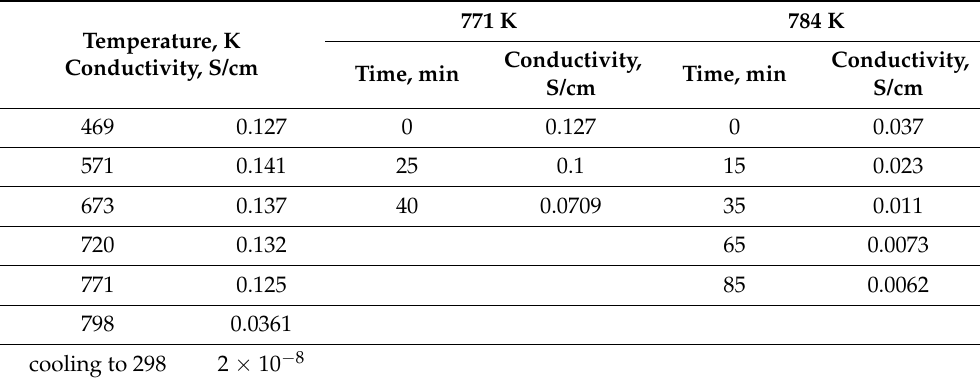
Table 4. The conductivity of 5 GAlN composite at different temperatures and thermal evolution of conductivity at 771 K and 784 K.